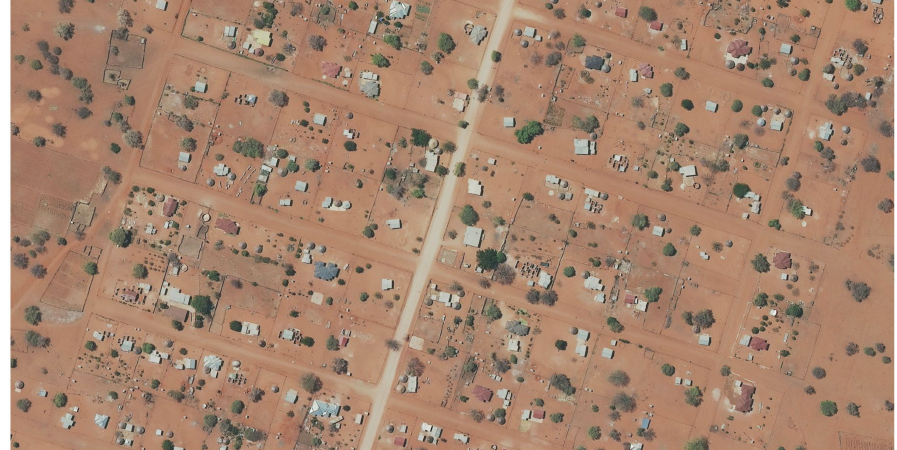
Figure 2. Extract from 2018 rectified imagery [12], (Ref: 2230 BC 22), showing part of a rural village known as Tshiungani, a government-initiated settlement scheme in the Limpopo Province, at scale: 1:5000